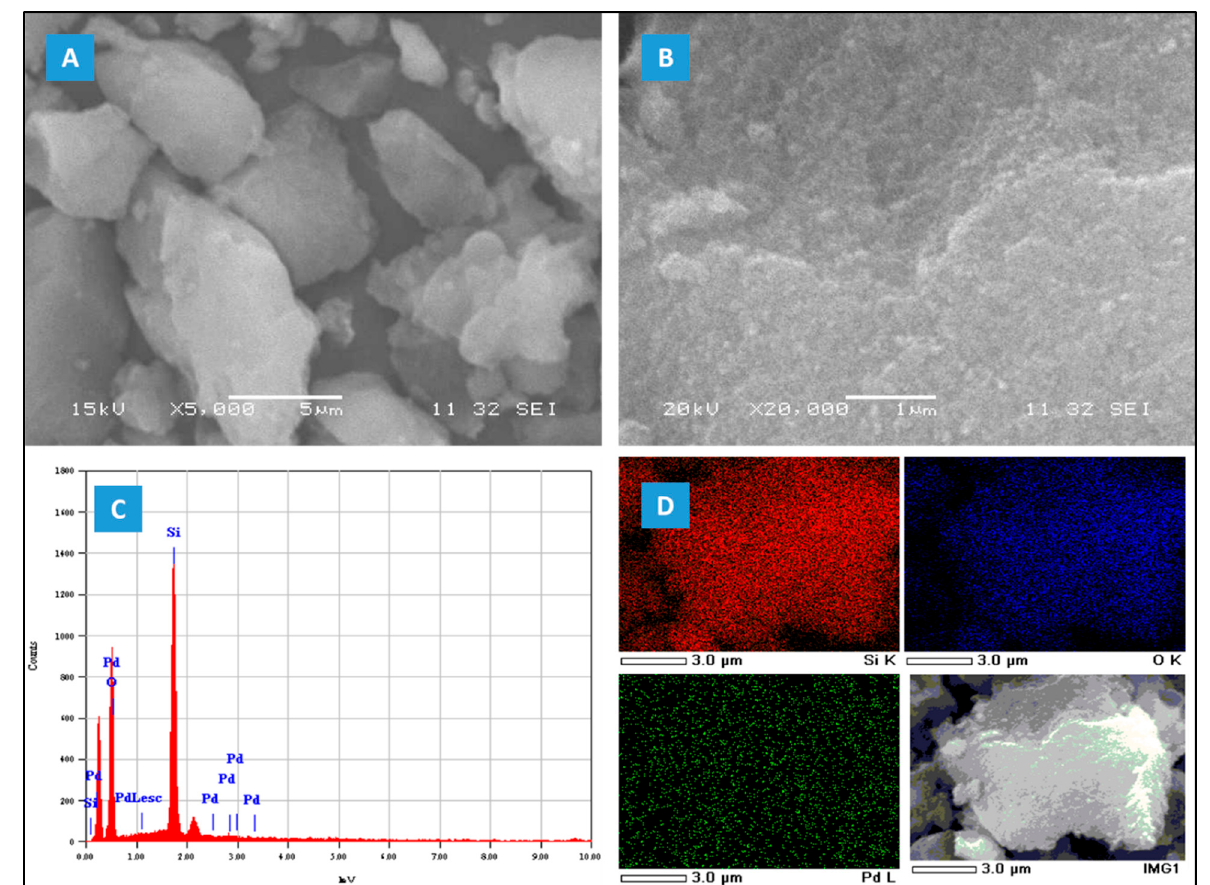
Figure 2. SEM analysis of the prepared Pd-SiO 2 sample. ( A , B ) are the micrographs of the sample with different magnifications, ( C ) EDX analysis, and ( D ) the elemental mapping of the sample.